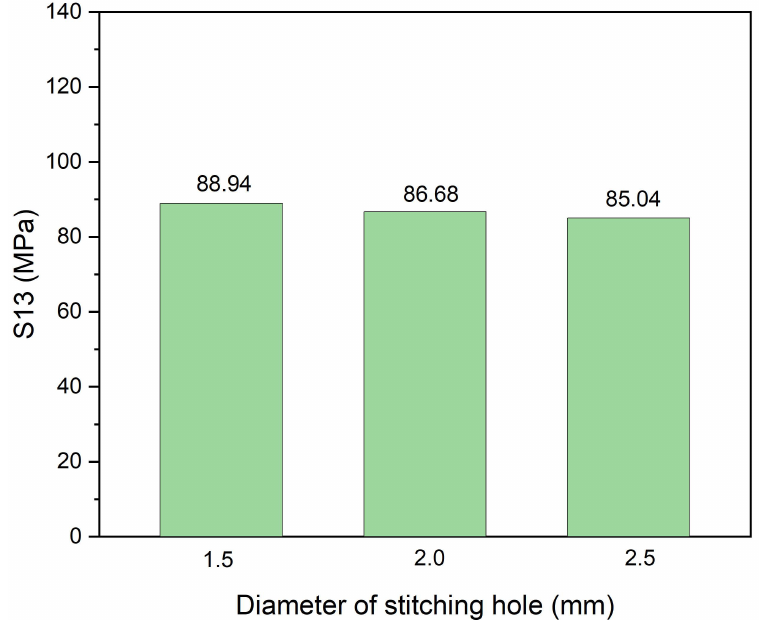
Figure 9. Maximum interlaminar shear stress (S 13 ) in